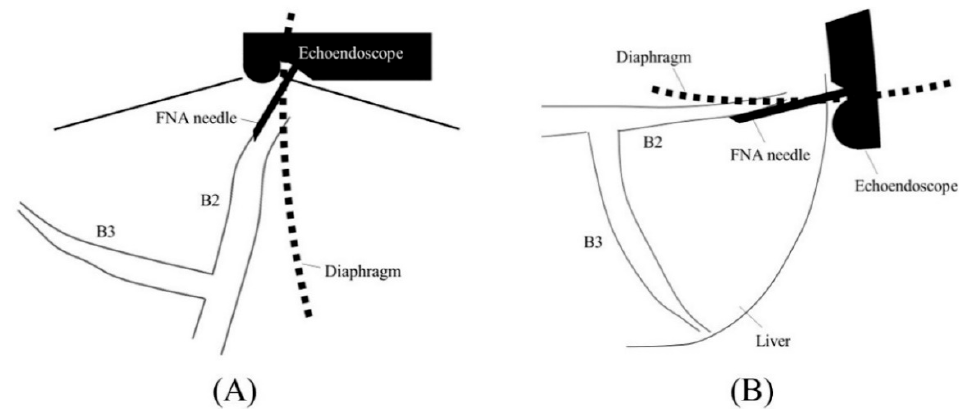
Figure 5. Too shallow echoendoscope position in B2 puncture. In a shallow scope position, a needle and B2 are parallel to each other, making puncture difficult and increasing the risk of transesophageal puncture (( A ); ultrasound image, ( B ); fluoroscopic image).